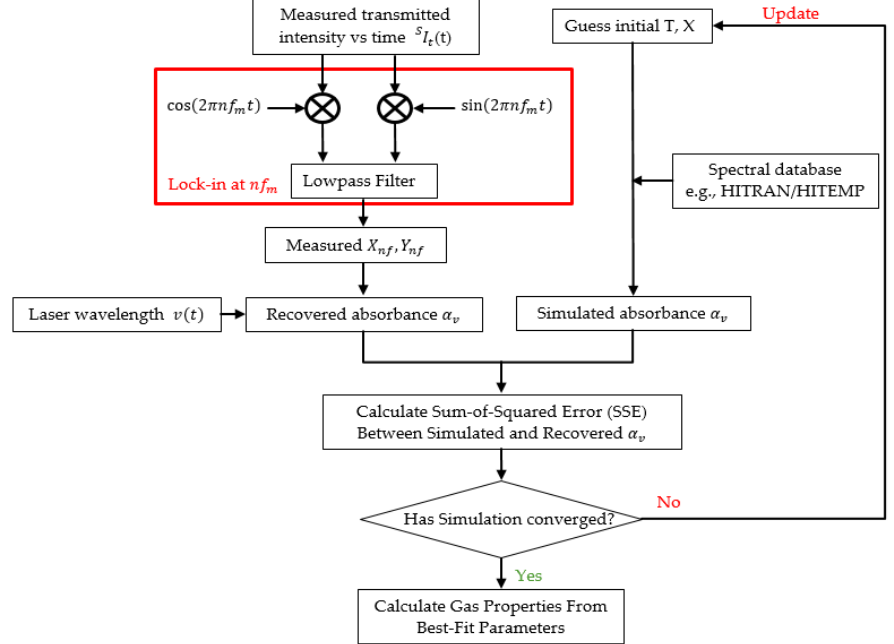
Figure 6. Flow chart of the recovery process of the absorbance profile based on higher-order harmonic signals.